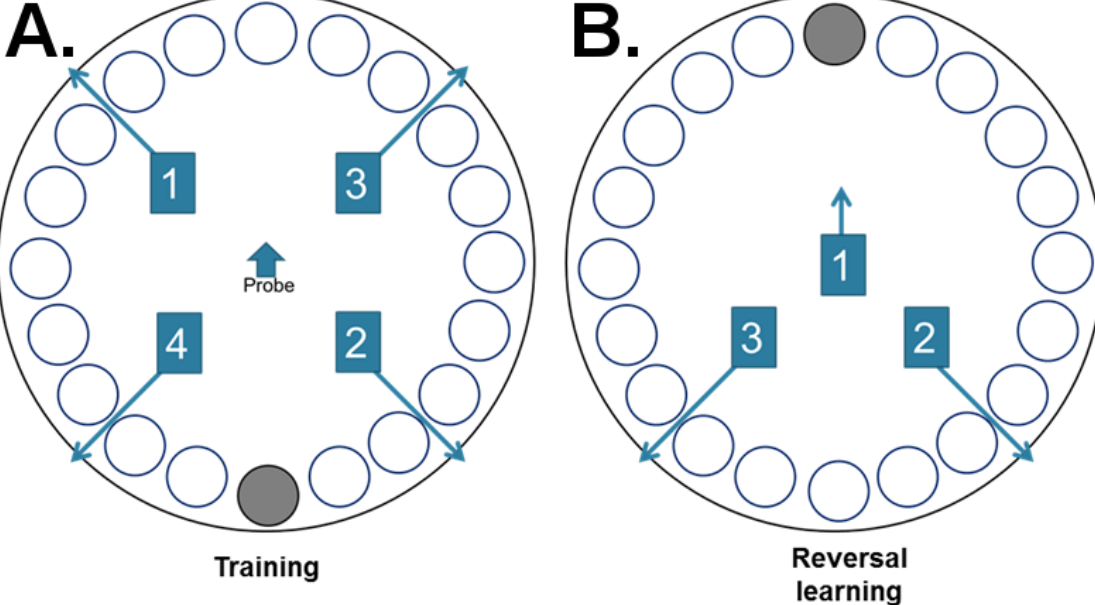
Figure 2. Barnes maze. Starting locations on the Barnes maze for training and reversal learning trials. ( A ) Rats underwent 4 trails/day during training. ( B ) On the testing day, rats went through a probe trial to assess task acquisition and 3 reversal learning trials to assess behavioral flexibility.